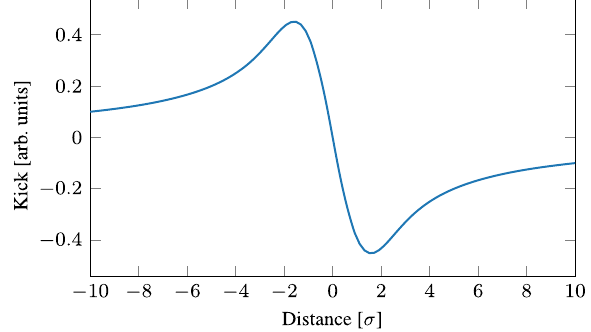
FIG. 1. The beam-beam force for round beams. The amplitude is in arbitrary units, the separation in units of the rms beam